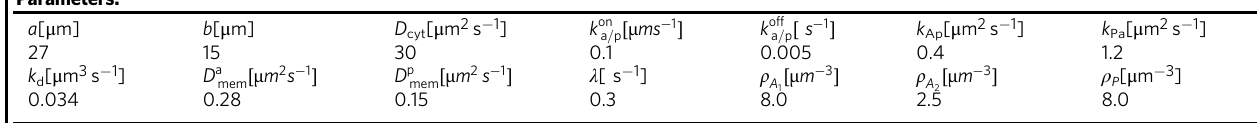
Table 4 Parameters for three-dimensional FEM